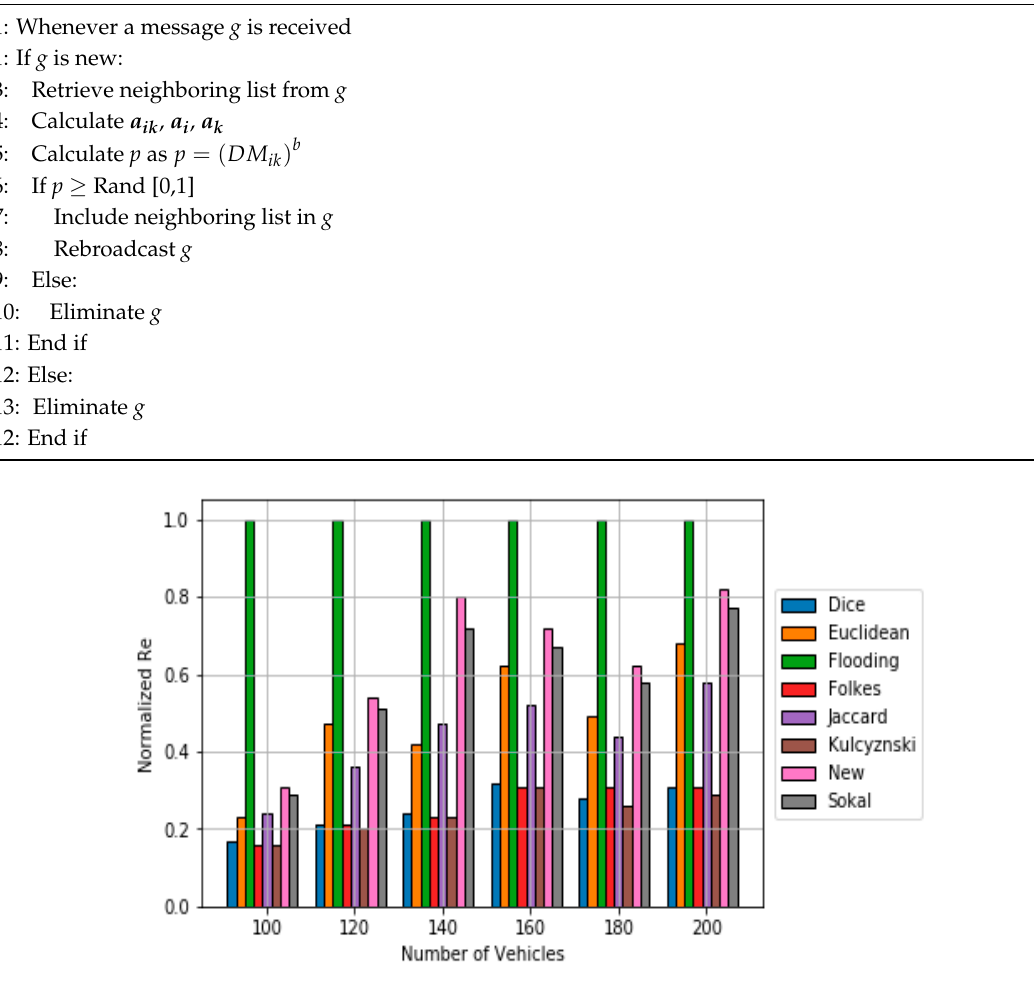
Figure 8. Comparison of Reachability results for the polynomial scheme based on the different dissimilarity metric.